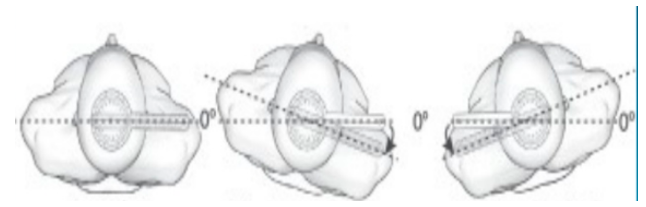
Figure 2. Rotation ROM assessment.